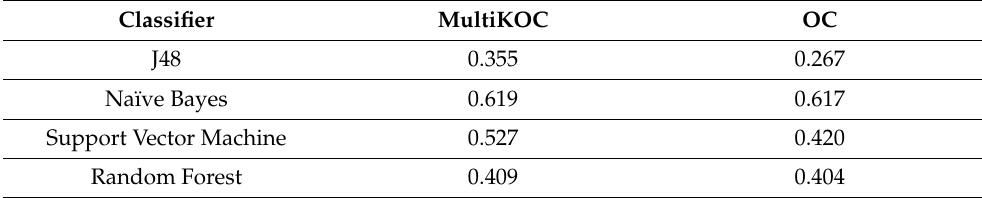
Table 6. Results summary for all the classifiers from the different